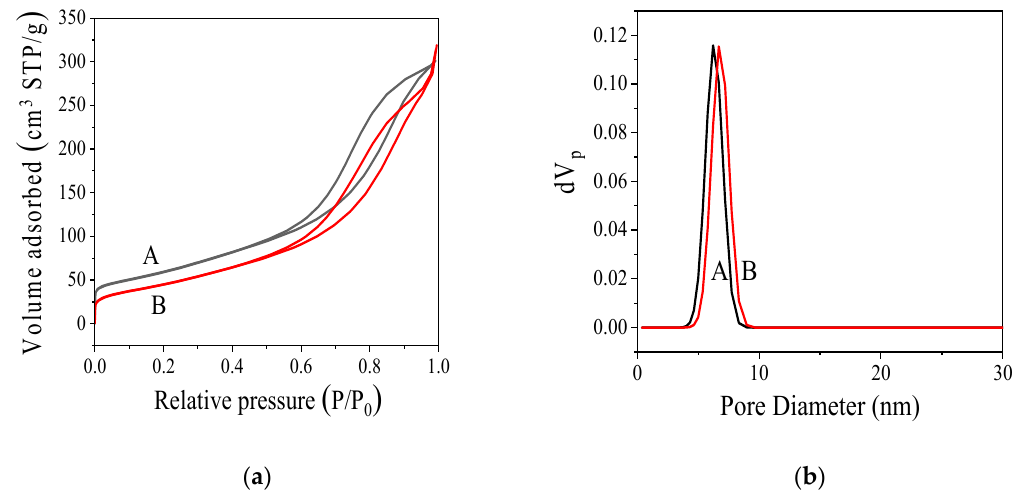
Figure 4. Nitrogen adsorption—desorption isotherms ( a ) and pore size distribution ( b ) of MC (A) and MC-COOH (B). Table 1. Pore structure parameters of MC and